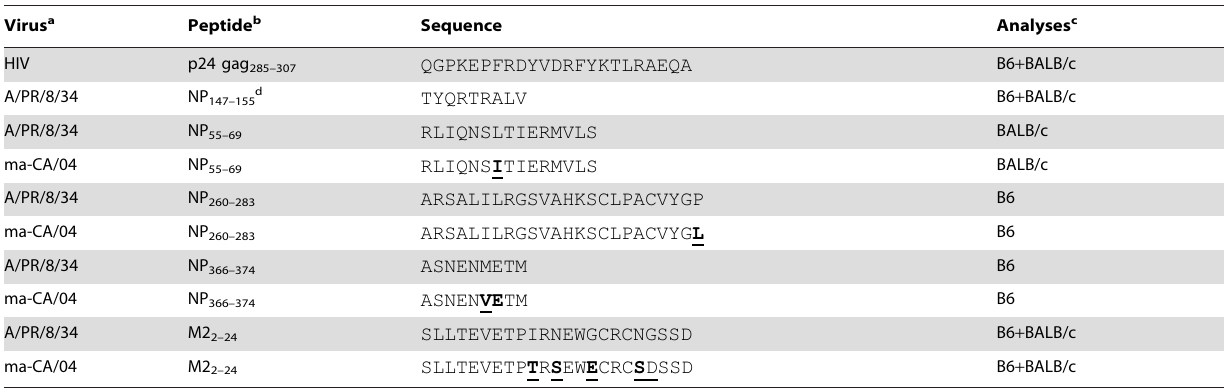
Virus a Peptide b Sequence Analyses c